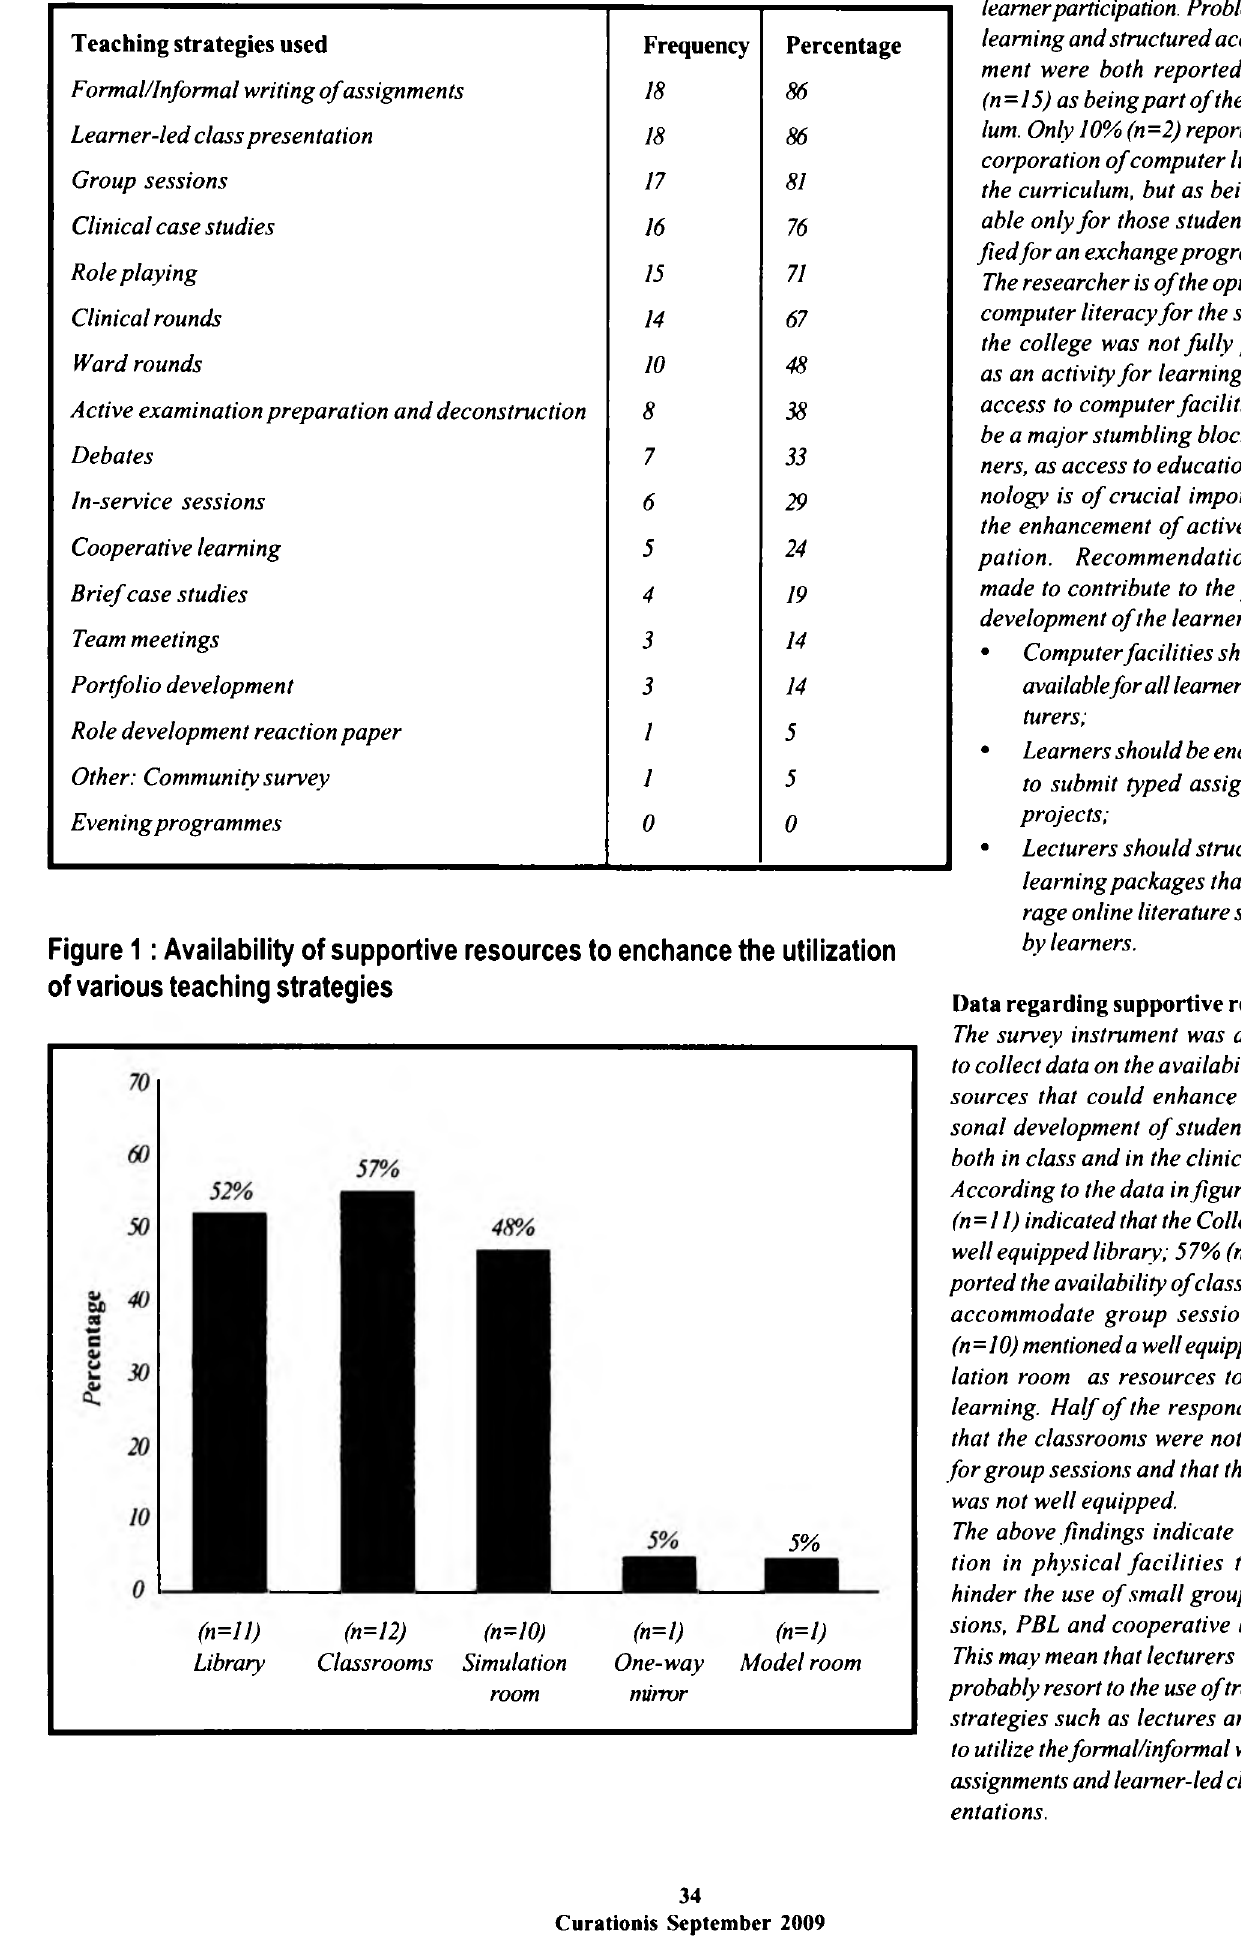
Table 1. Teaching strategies used when facilitating learning Teaching strategies used